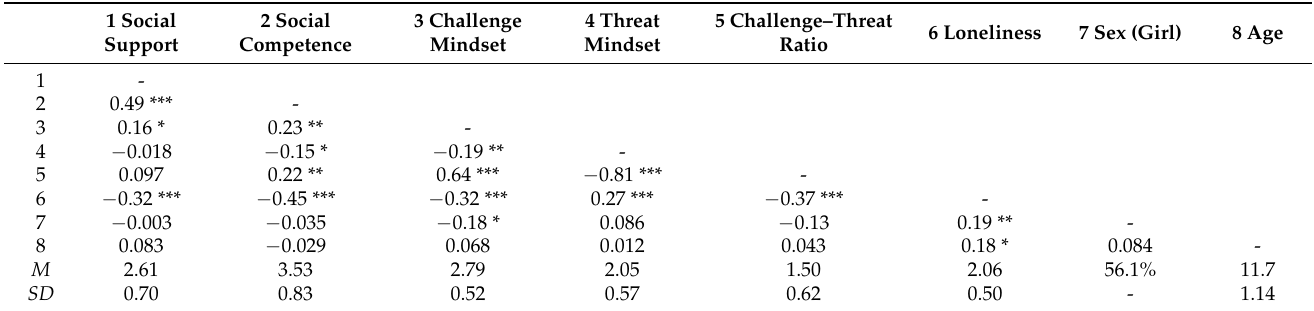
Table 1. Descriptive statistics and bivariate correlations among all main